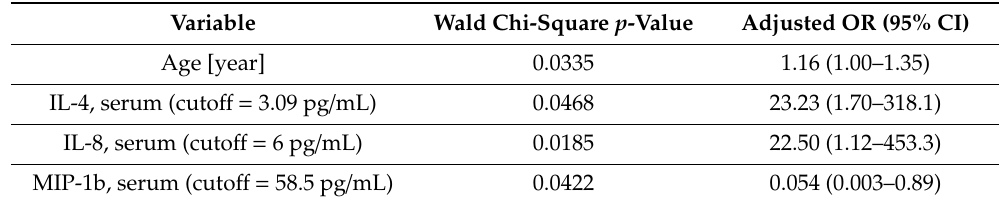
Table 3. Association between the TA-specific response and the cytokine data. Results from the multiple logistic regression model for the TA-specific response with the variables IL-4, IL-8, and MIP-1b (dichotomized) and age (continuous). Odds ratios are provided for values below the respective optimal cutoffs (reference group “ ≥ cutoff” with OR = 1).